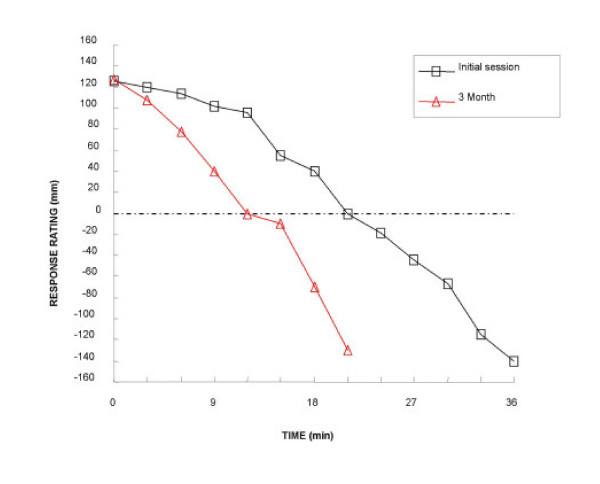
A representative satiation kinetic from one obese participant (Class I) at Initial session and 3 mo following a commercial regimen (Minçavi®). The curve shows that time to reach zero rating significantly decreased from 21 min at Initial session to 12 min at 3 mo on diet. The figure also shows that the overall time to abandon the experimental session, negative alliesthesia, was significantly decreased from 36 min at Initial session to 21 min at 3 mo on diet. From this satiation kinetic, the initial rating of pleasure (Initial session 125 mm) remained the same (3 mo 127 mm). The amplitude of rating (minimal and maximal hedonicity) was also similar from Initial session to 3 mo.